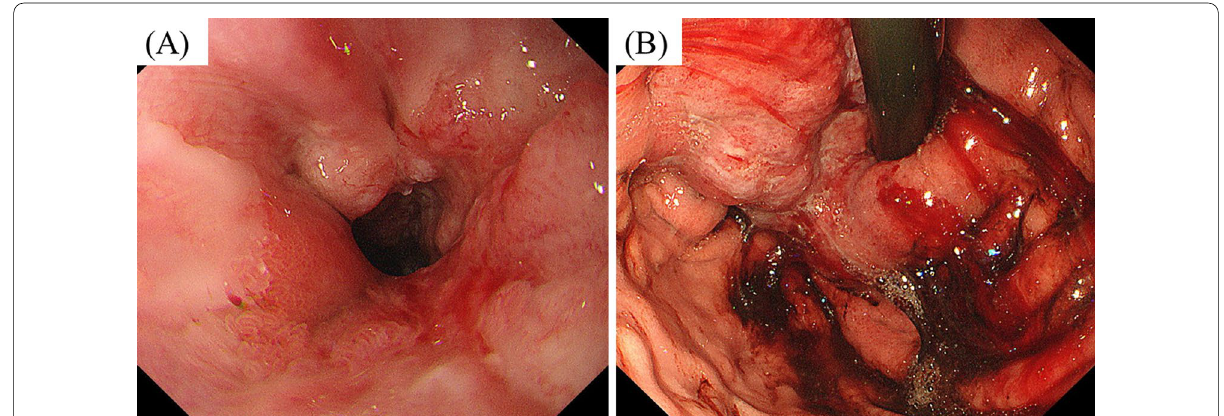
Fig. 1 A The tumor occupying the entire circumference of the gastroesophageal junction. B The tumor was associated with hemorrhage and ulcer formation in the central area